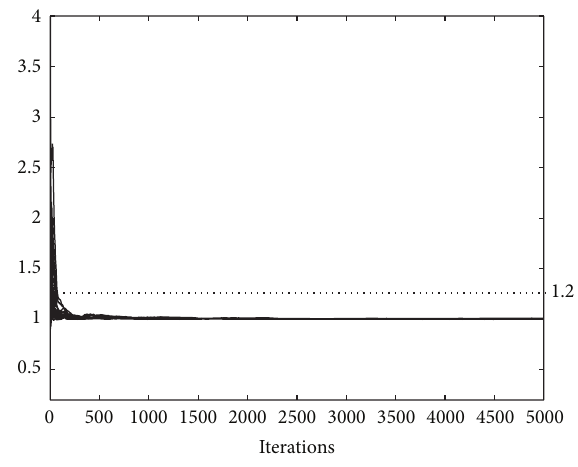
Figure 1: Plot of the values of EPSR of unknown parameters against the number of iterations under different starting values for the simulated